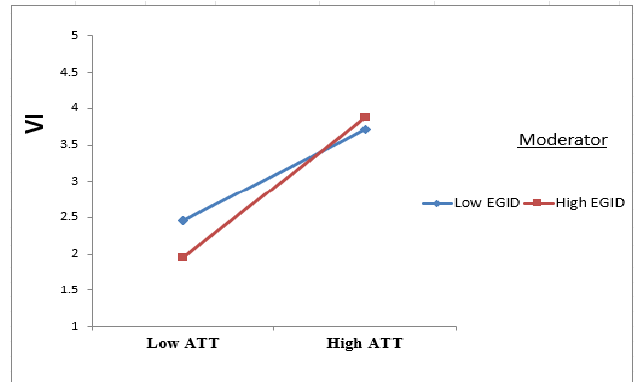
Figure 4. EGID moderation effect on ATT toward VI.